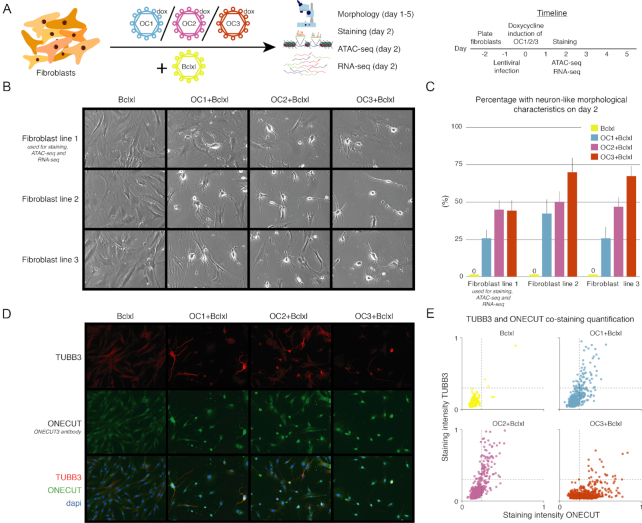
Phenotypic effects of ONECUT overexpression in fibroblasts. (A) Outline validation experiments. Human fibroblasts were lentivirally transduced with the ONECUT1 (OC1), ONECUT2 (OC2) or ONECUT3 (OC3) transgene together with the anti-apoptotic transgene Bclxl. We assessed morphology, neuronal marker expression, ATAC-seq and RNA-seq. (B) Cell morphology on day 2 after induction of OC1/2/3 overexpression in three different adult human fibroblast cell lines overexpressing Bclxl. Fibroblast line 1 was used for stainings, ATAC-seq and RNA-seq. (C) Percentage of cells with neuron-like morphological characteristics two days after OC1/2/3 induction for all three fibroblast lines. (D) Co-staining for TUBB3 and ONECUT (anti-ONECUT3 antibody, see methods) 2 days after OC1/2/3 induction in fibroblast line 1. (E) Quantification of the mean staining intensity at individual nuclei for TUBB3 and ONECUT. Shown are 668 nuclei per condition. The horizontal and vertical dotted lines are there to help compare OC1+Bclxl, OC2+Bclxl and OC3+Bclxl to the Bclxl condition.